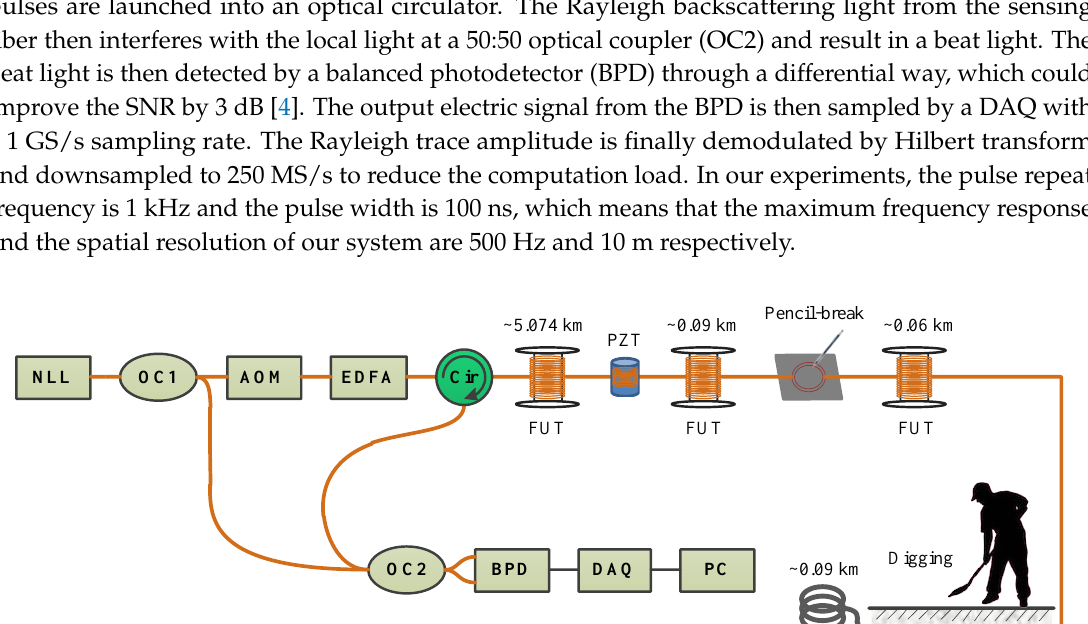
Figure 2. The vibration locating results when coherent fading problem exists. ( a ) 100 averaged Rayleigh traces; ( b ) The spatial kurtosis (SK) and special average kurtosis (SAK) curves of the Rayleigh traces.